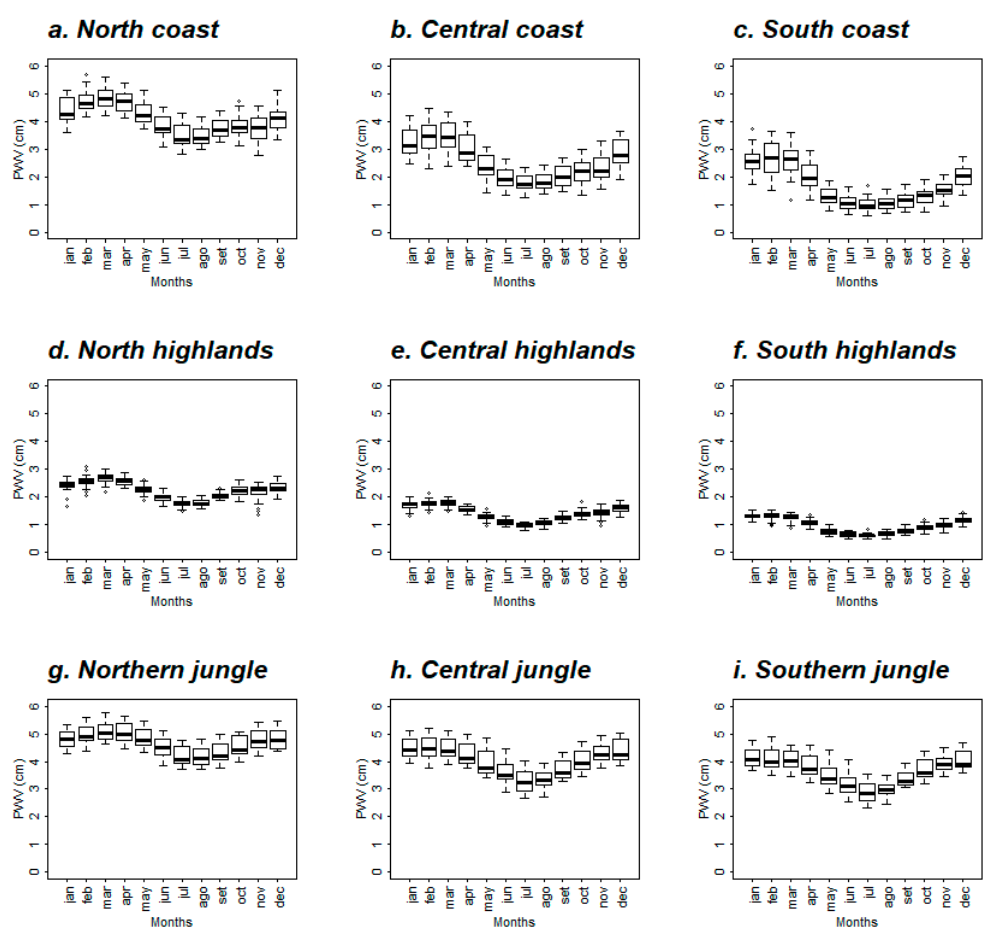
Figure 9. Boxplots of monthly PWV extracted from MODIS product for the different sub-regions: ( a ) North Coast, ( b ) Central Coast, ( c ) South Coast, ( d ) North Highlands, ( e ) Central Highlands, ( f ) South Highlands, ( g ) North Jungle, ( h ) Central Jungle, and ( i ) South Jungle. Boxplots include the first and third quartile (lower and upper limits of the box, respectively), the median (thick line inside the box), the maximum and minimum (whiskers), and outliers (points above or under the boxes) values.